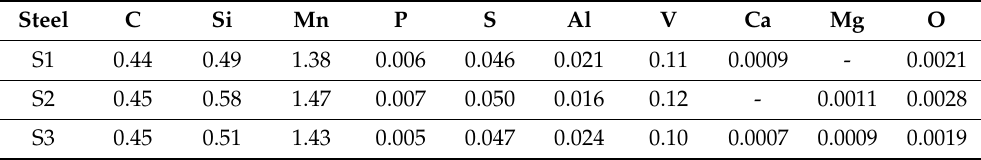
Table 1. Chemical compositions of the steels used in experiments (mass%).